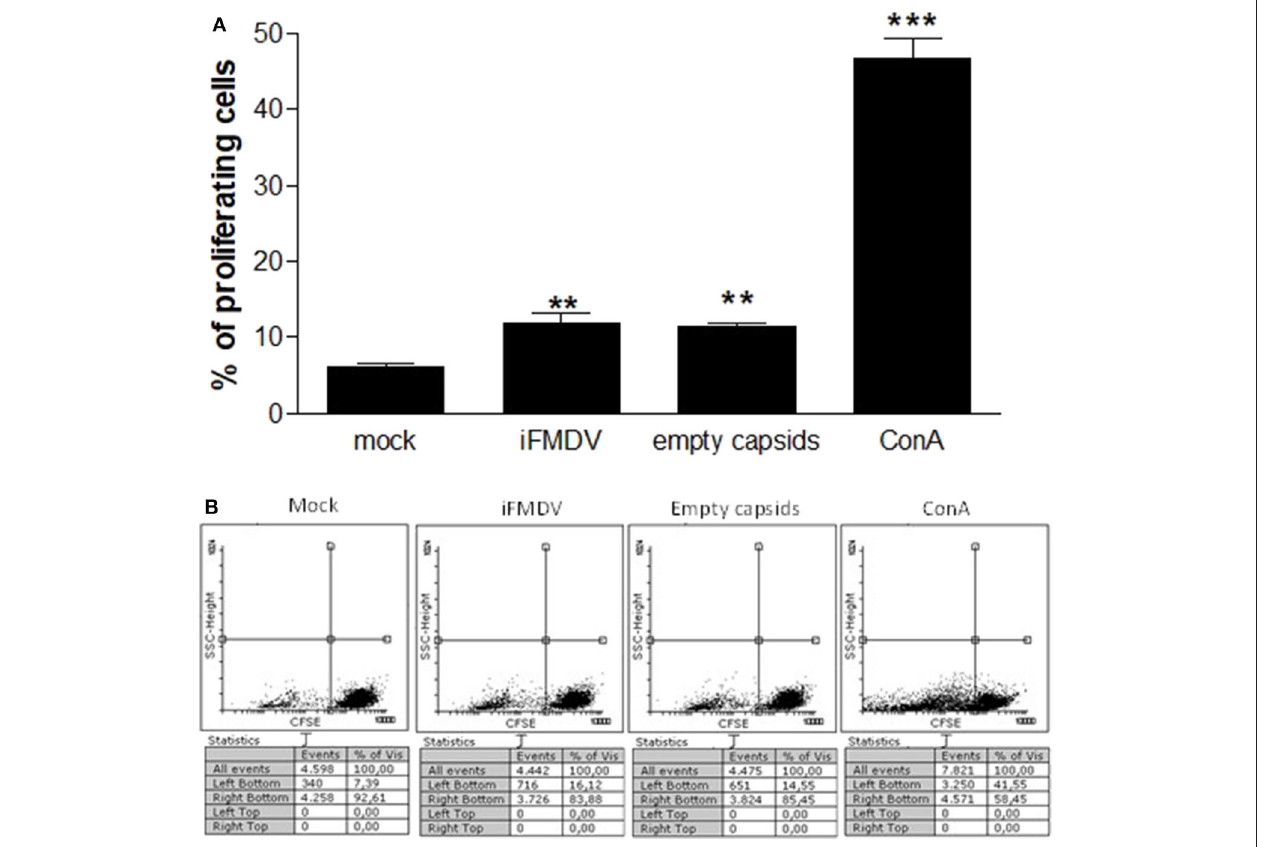
FIGURE 2 | Co-cultures of lymph cells incubated with iFMDV or empty capsids, and CFSE-labeled PBMCs. (A) Results are expressed as percentage of proliferating PBMCs. Mock = ALDCs incubated with supernatant from non-transfected cells. ** and *** represent a significant difference ( p < 0.01 and p < 0.001 respectively) regarding mock control. Mean of triplicates + SD of one representative graph of two independents assays, are shown. (B) A representative dot plot of CFSE lost for each group is